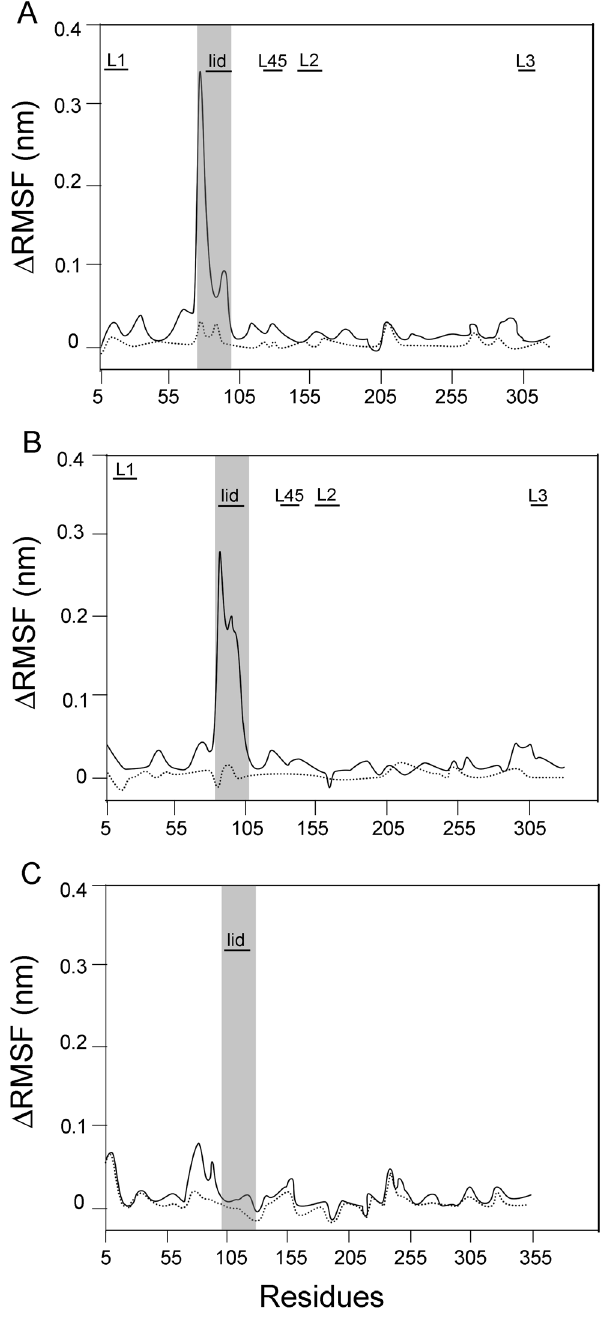
Figure 5. Analysis of BsNTD, TmNTD and PMS1 monomers residues mobility using structure based models (SBM). Root Mean Squeare Fluctuation (RMSF) difference between apo and ATP- bound (full black line) and ADP and ATP-bound monomer (dotted line) for; A) BsNTD B) TmNTD and C) yeast PMS1 were calculated from SBM MD simulations. Dimerization interface is indicated with black horizontal bars. ATP lid residues are marked with grey shadow. doi:10.1371/journal.pone.0069907.g005 the server DNABindR [44] for prediction of protein-DNA interaction sites was used to predict PaNTD residues involved in DNA contact (Figure S6). This server is trained to predict whether a given amino acid residue is a DNA-binding residue based on its